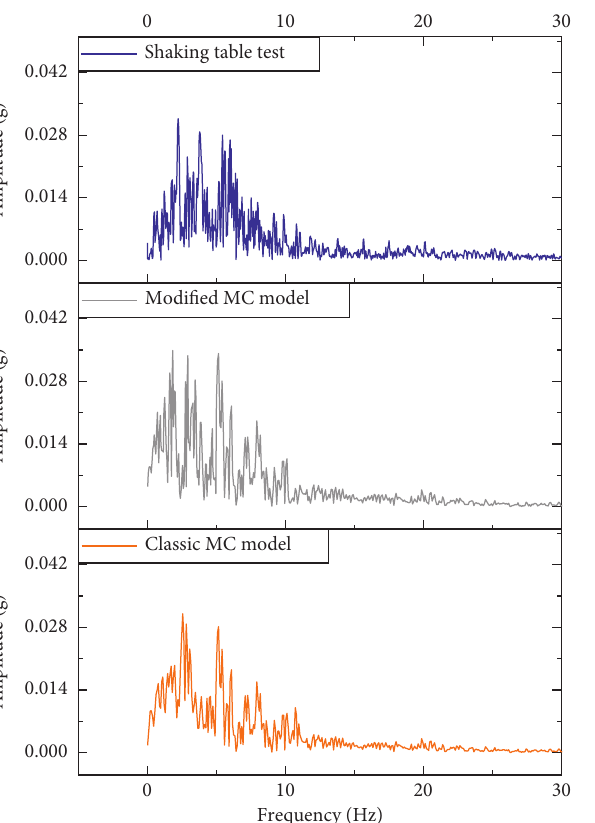
Figure 15: Frequency-domain analysis of point A5H.